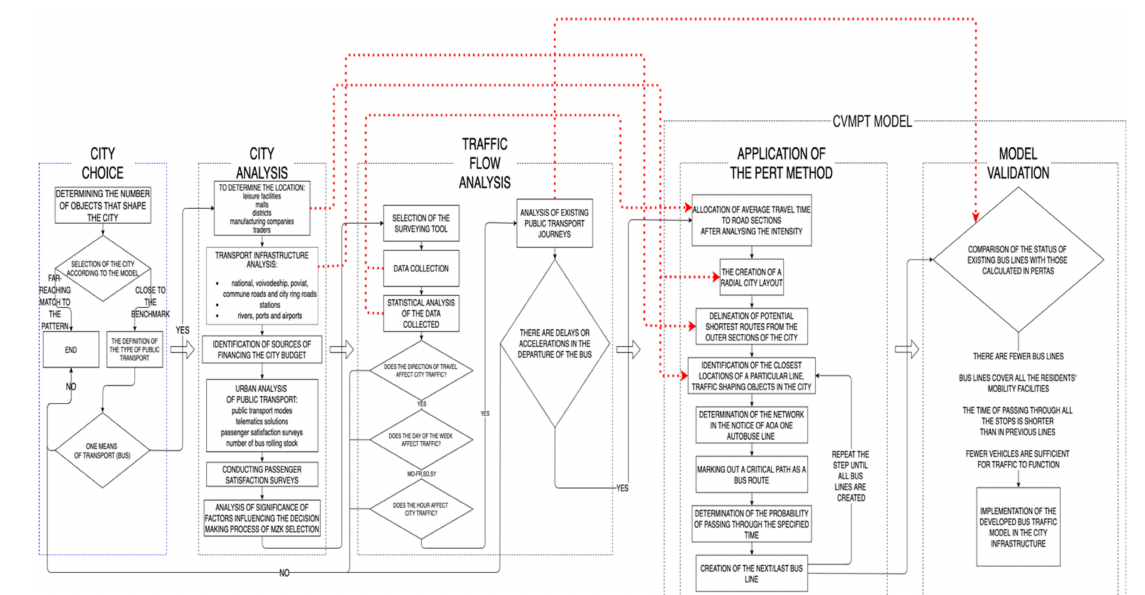
Figure 1. The diagram presenting the procedure for applying the PERT method in public transport route